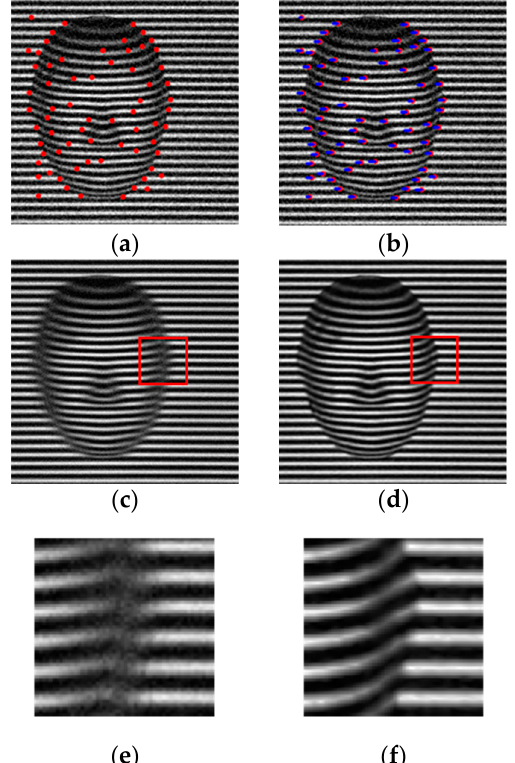
Figure 5. Low-resolution deformed patterns and super-resolution reconstructions: ( a ) Reference; ( b ) 𝐼 (cid:4593)(cid:4593) (cid:2869)(cid:2872) with matching points; ( c ) Reconstruction by averaging; ( d ) Reconstruction by MAP; ( e ) Enlargement of rectangular area in Figure 5c; ( f ) Enlargement of rectangular area in Figure 5d.